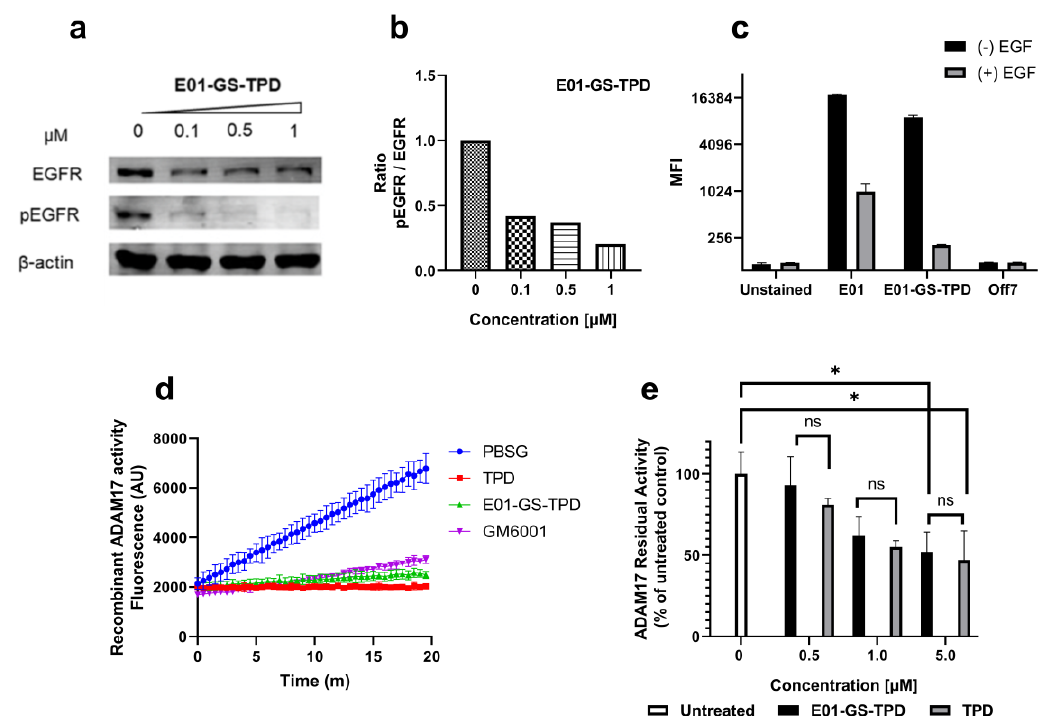
Figure 3. E01-GS-TPD inhibits EGFR phosphorylation and ADAM17 activity in vitro. ( a ) A431 cells were treated with fusion protein E01-GS-TPD at increasing concentrations for a total of 48 h; the levels of total EGFR and phosphorylated EGFR (pTyr1068) were analyzed by Western blot. ( b ) the levels of phosphorylated EGFR relative to total EGFR were calculated based on band intensity and normalized to the untreated control (0 µM) . ( c ) to evaluate ligand competition for receptor binding, A431 cells were treated with E01-sfGFP or E01-GS-TPD-sfGFP at 1 µM in the presence or absence of EGF (2 µM). Mean fluorescence intensity was measured. ( d ) to examine the ability of E01-GS-TPD to inhibit ADAM17 activity, recombinant ADAM17 was co-incubated with TPD, E01-GS-TPD, or the broad- spectrum matrix metalloproteinase (MMP) inhibitor GM6001 (2 µM). The increase in fluorescence